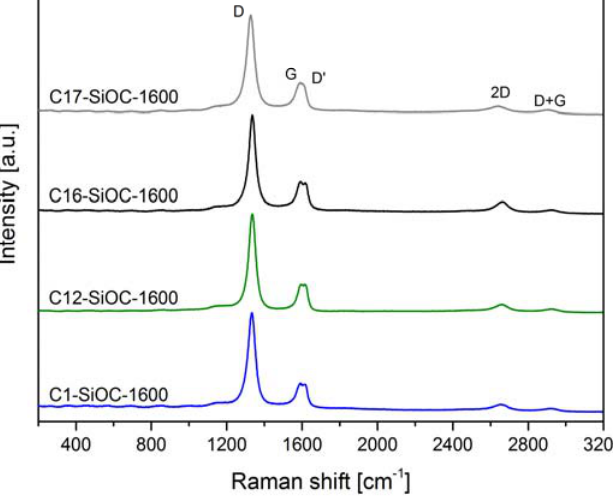
Figure 2. Raman spectra of the hot ‐ pressed SiOC glass ceramics.